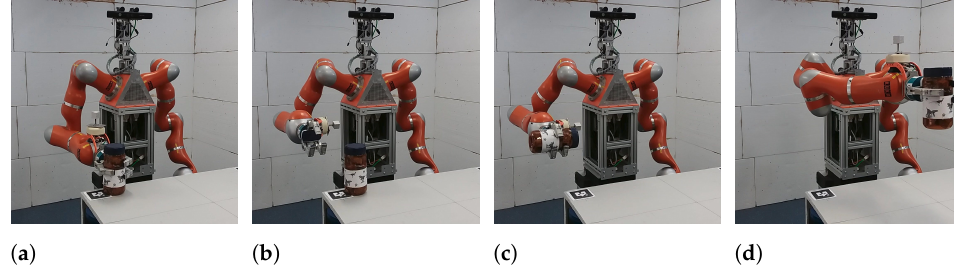
Figure 12. The partial illustration of the tests on the real robot—Velma: ( a – c ) stage 1, ( d ) stage